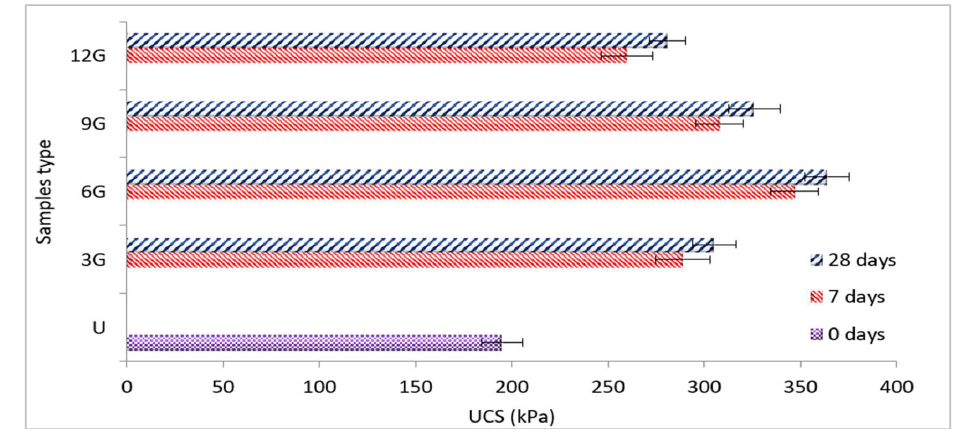
Figure 3. UCS of soil with different GGBS contents at 7 and 28 days of